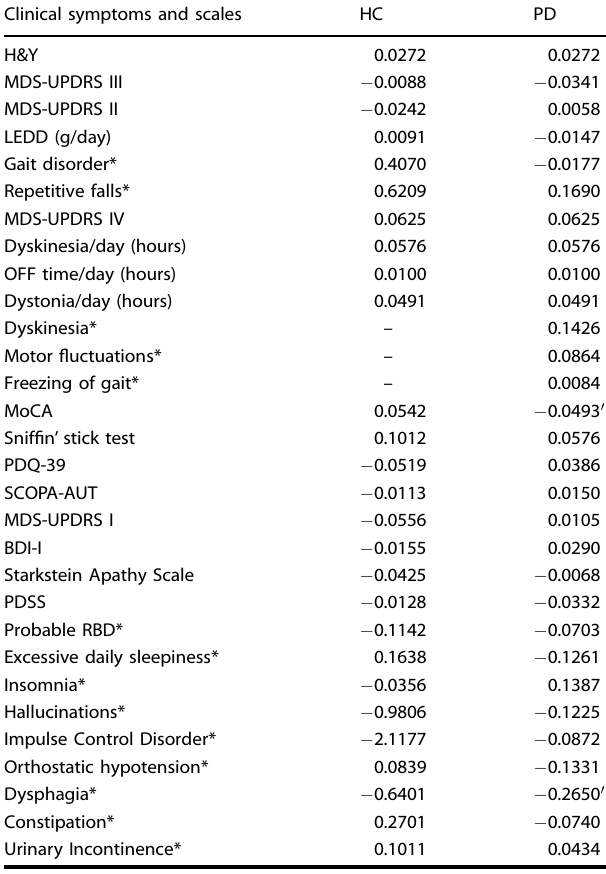
Table 6. Kendall correlation coef fi cient between clinical outcome (row) and polygenic risk score (PRS) for healthy controls (HC) (left) and Parkinson ’ s disease patients (PD) (right), with annotation by bold indicating signi fi cant effect where minus value indicates negative signi fi cant effect and positive value positive signi fi cant effect respectively (Kendall correlation test).